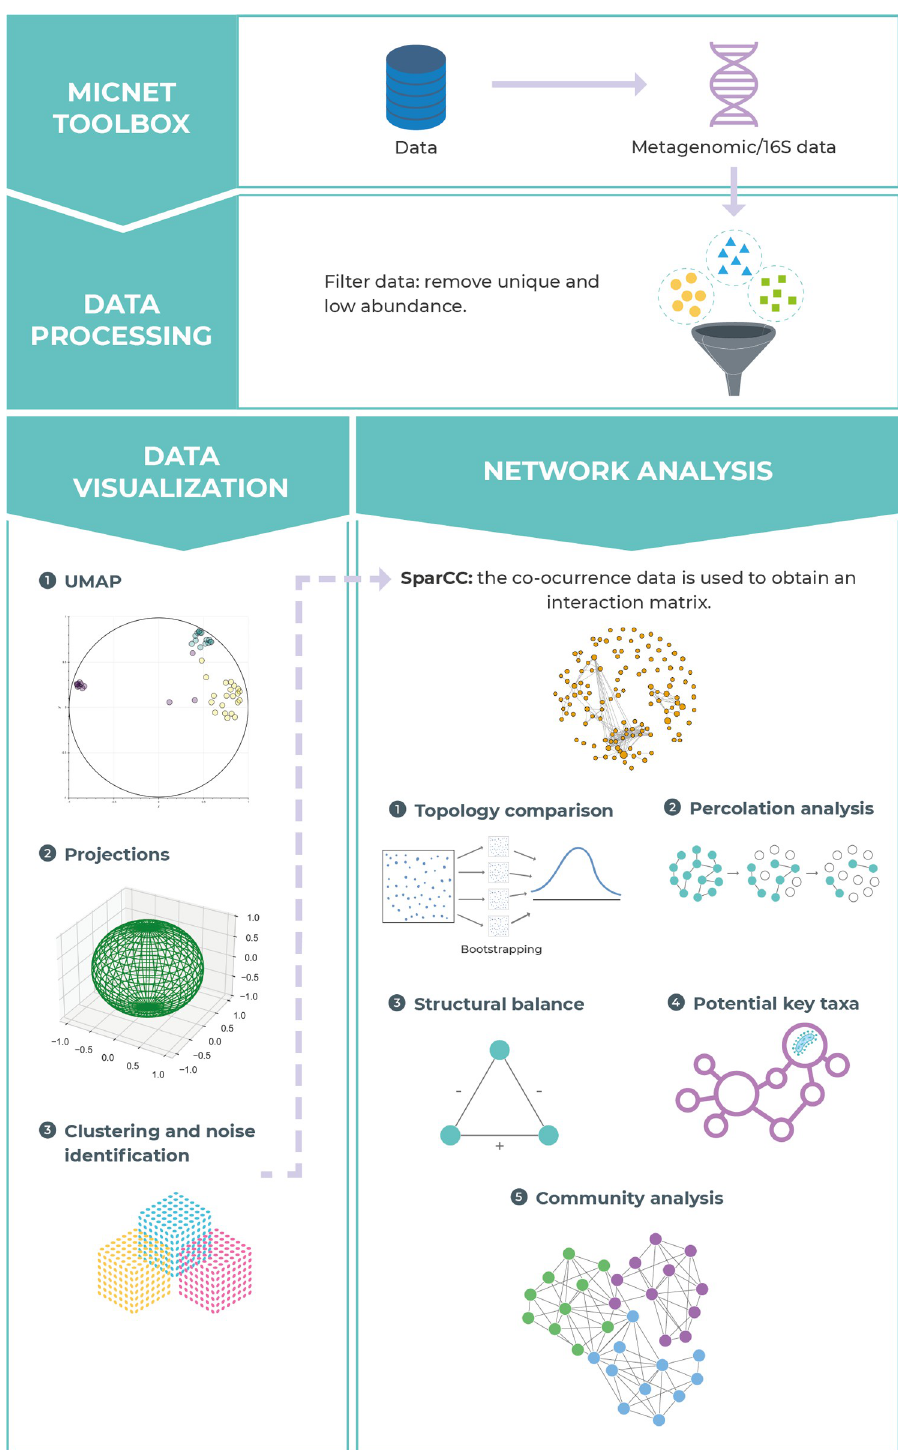
Fig 1. Overview of MicNet toolbox. MicNet Toolbox was designed for visualizing, creating and analyzing microbial networks obtained from compositional data (obtained through high-throughput sequencing methods such as metagenomic/16S surveys). Data filtering for singletons and low abundance taxa/ASV/OTU is supported if required. MicNet Toolbox includes two independent main modules: a data visualization module which uses UMAP and HDBSCAN to find local patterns in the data, and a network analysis module which implements an enhanced version